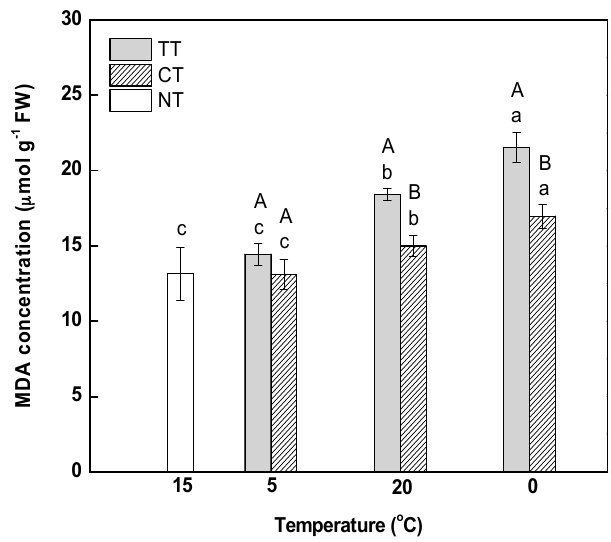
Figure 2. Effect of calcium on malondialdehyde (MDA) content in M. baccata leaves under temperature stress. TT , temperature treatment; CT , calcium treatment; NT , control. Lowercase letters above the bars indicate significant difference at p < 0.05 (Duncan’s test) of different treatments at the same temperature. Capital letters above the bars indicate significant difference at p < 0.05 (Duncan’s test) of the same treatment at different temperature.